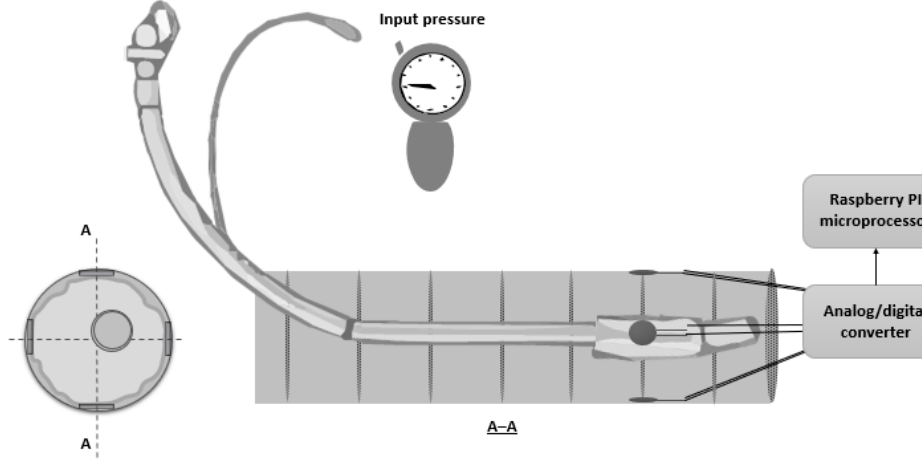
Figure 1. Front view and longitudinal cross-section of the prototype.